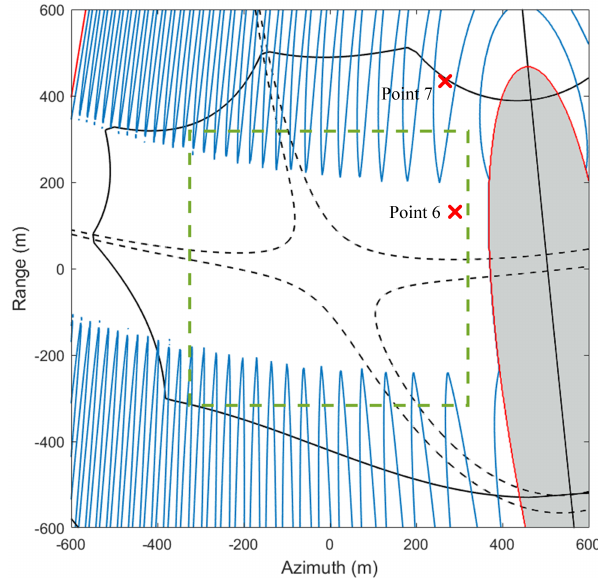
Figure 15. Swath limits for residual phase error of three algorithms and the distribution of simulated scatterers. The black dotted, blue and red contour lines represent the residual phase error of zero-layer ML-OSA, one-layer ML-OSA and two-layer ML-OSA, respectively.